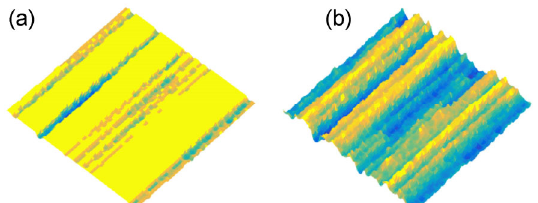
Fig. 10 Two initially smooth surfaces after being subjected to wear as described in Sec. 4.2 with a rough counterpart similar to Fig. 7(a). (a) At light load 0.01   p , many contacts slide but do not generate particles and the surface remains undamaged at these spots. (b) With more severe loading at 0.1   p , a larger part of the surface is worn. Other parameters as in Fig. 4.